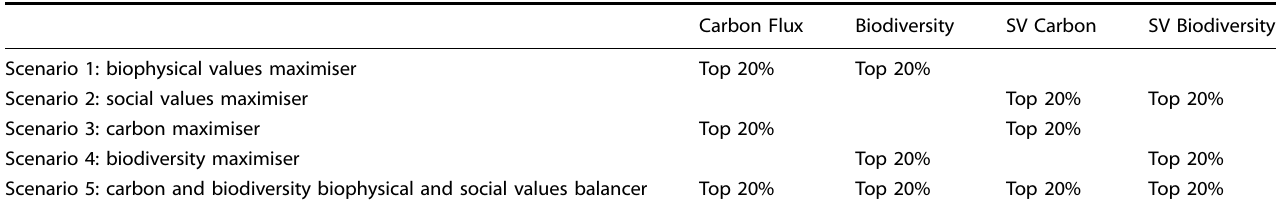
Table 4. Five scenarios represented by the overlap areas between top 20% pixel values for a range of combinations of carbon fl ux, biodiversity and SV for Carbon and